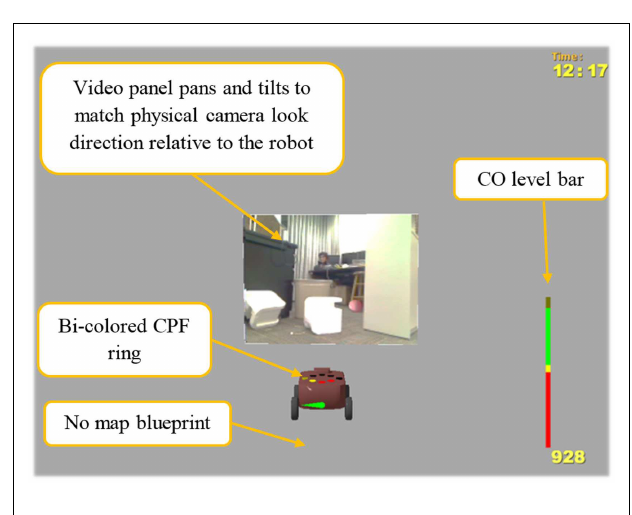
FIGURE 8 |Visual interface for study #4